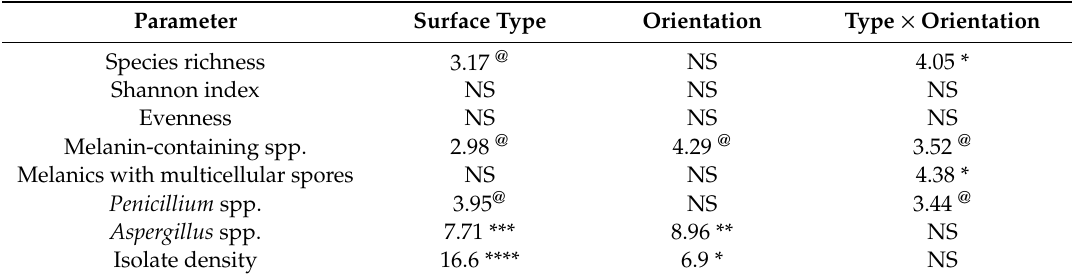
Table 3. Data of two-way unbalanced ANOVA analysis for the e ff ect of surface type (crusts dominated by di ff erent lichen species, cyanobacterial crusts, and bare surface), habitat position (north-oriented and plain sun-exposed), and interactions between them on di ff erent parameters of microfungal communities at the Tabernas